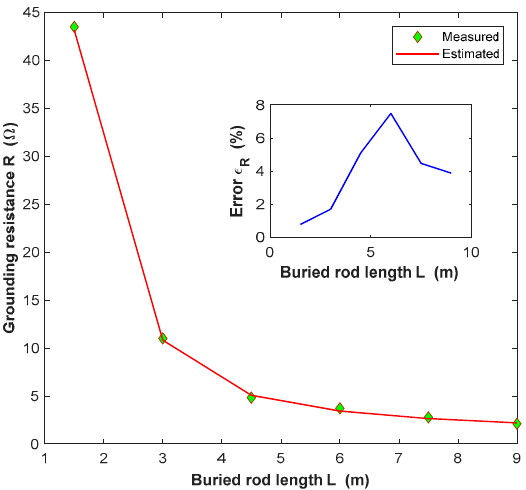
Figure 9. Measured and calculated grounding resistance in Castelldefels, Barcelona.